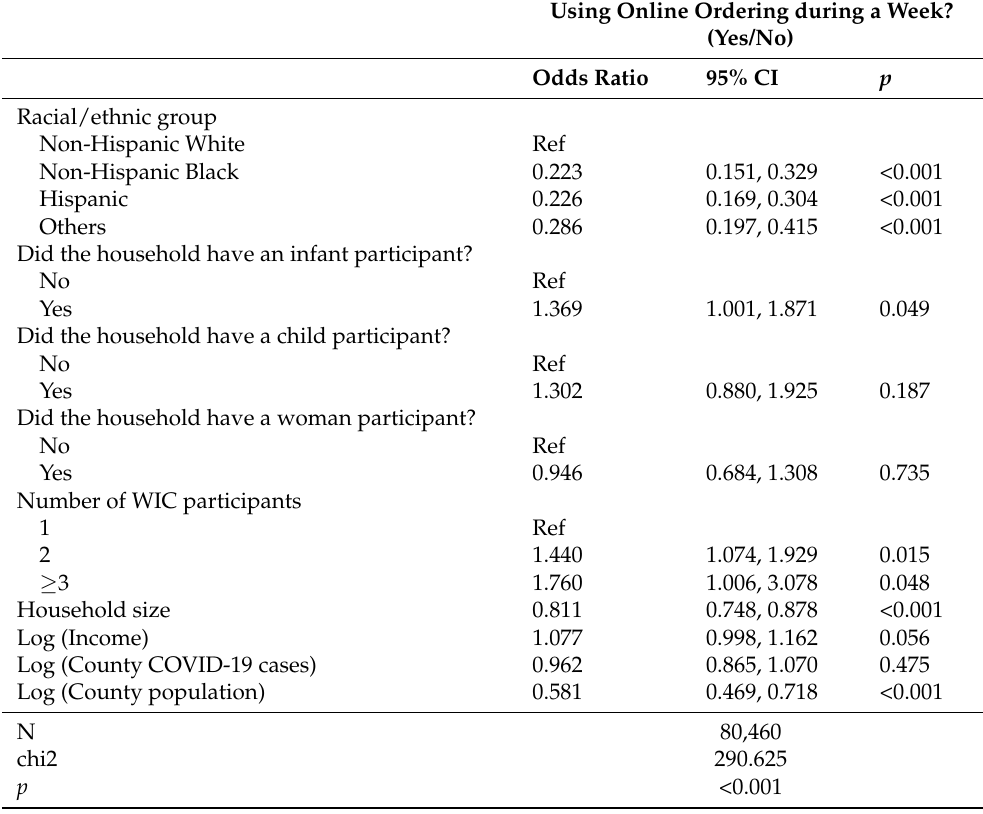
Table 2. Regression results of the random-effects model of weekly WIC online ordering adoptions among XYZ